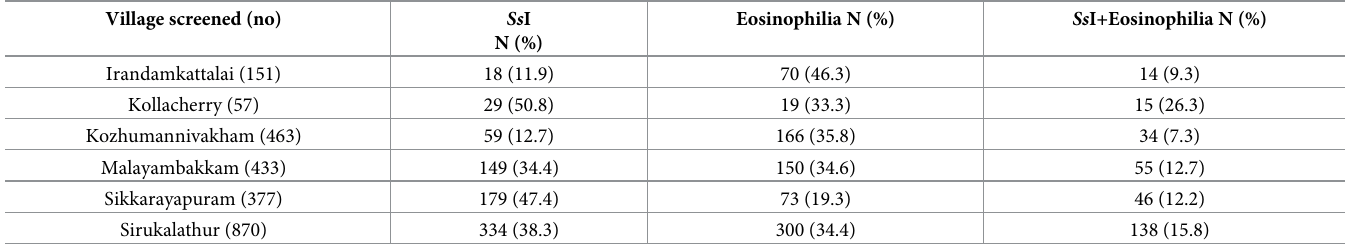
Table 3. Prevalence of Eosinophilia and Stongyloides stercoralis infection village wise. Village screened (no)